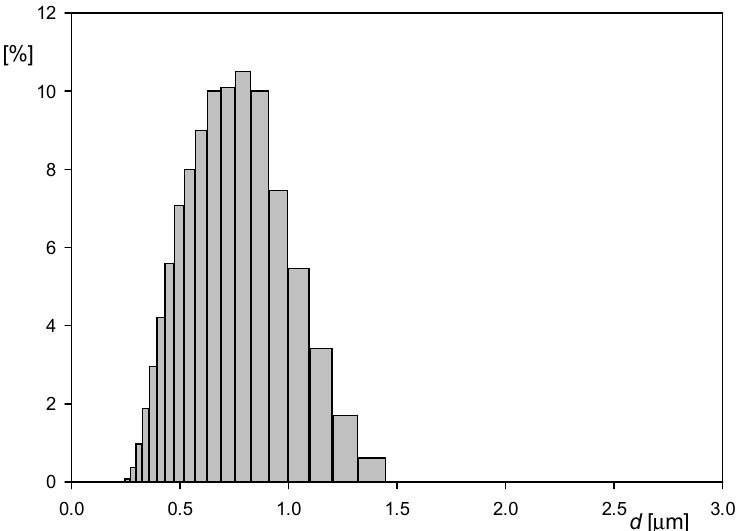
Figure 2. Histogram of the microparticle size distribution derived from laser diffractometry, the average particle size is equal to 810 ± 30 nm.